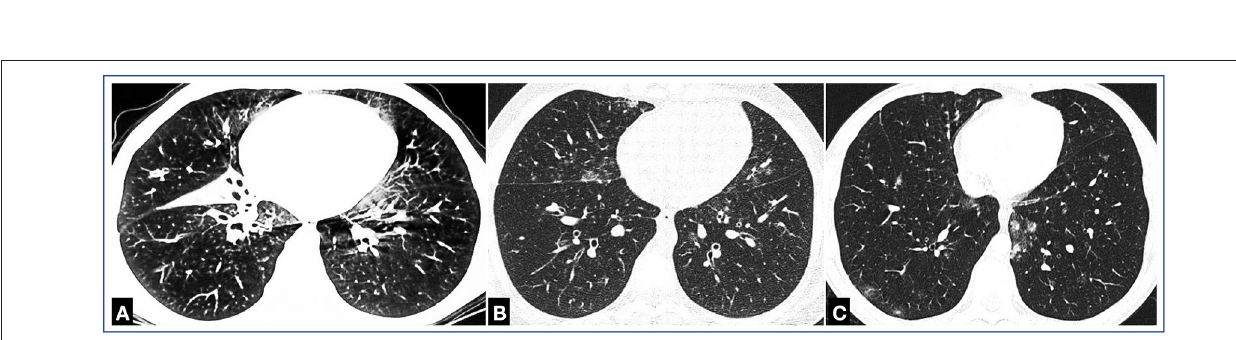
FIGURE 5 | Box plots reflecting distributions of out-of-range relative values (A,C,E) and absolute counts (B,D,F) of RTE, naive T helper, and regulatory Th cells in immune dysregulation vs. no dysregulation groups. (1) Autoimmunity vs. no autoimmunity ( n = 18 vs. n = 21, respectively); (2) Lymphoproliferation vs. no lymphoproliferation ( n = 14 vs. n = 25); (3) Asthma vs. no asthma ( n = 21 vs. n = 18); and (4) Malignancy vs. no malignancy ( n = 2 vs. n = 37).